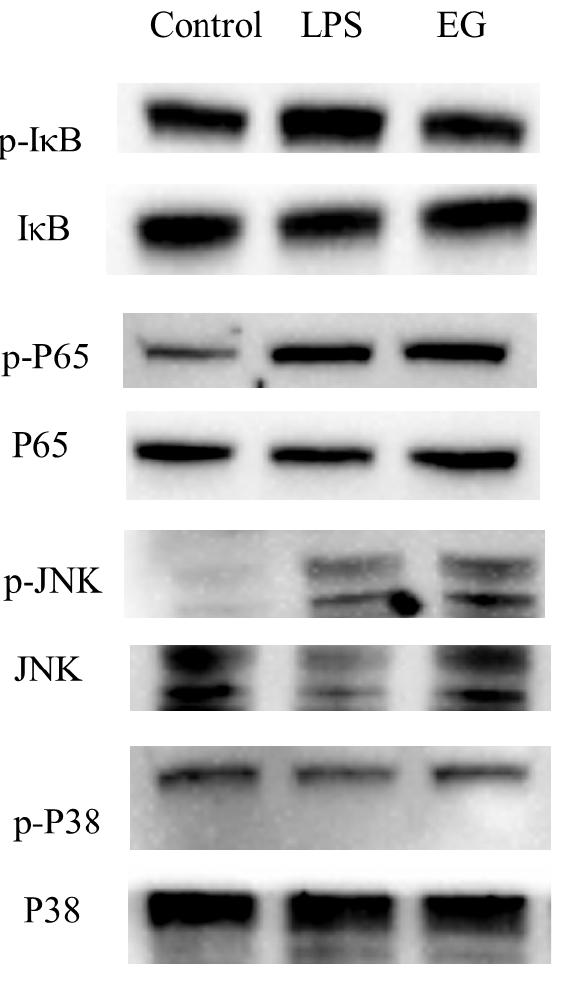
Figure 8. Expression and phosphorylation levels of key proteins on the Toll-like receptor pathway. The quantitative results of grayscale analysis are shown in Figure S2.